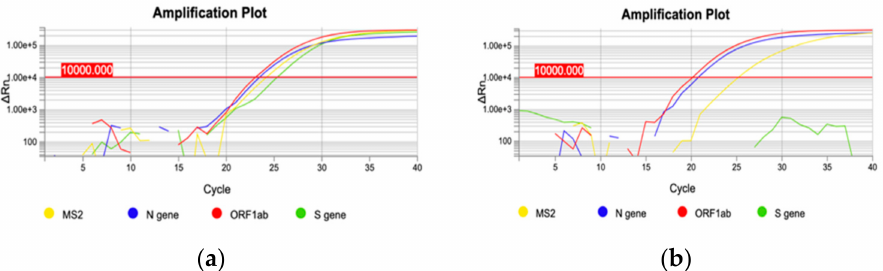
Figure 2. Two representative qRT-PCR amplification plots. ( a ) amplification of three targets: N gene, ORF1ab gene and S gene (blue, red and green curve, respectively); ( b ) S gene deletion: only N gene and ORF1ab gene targets are amplified (blue and red curve, respectively).